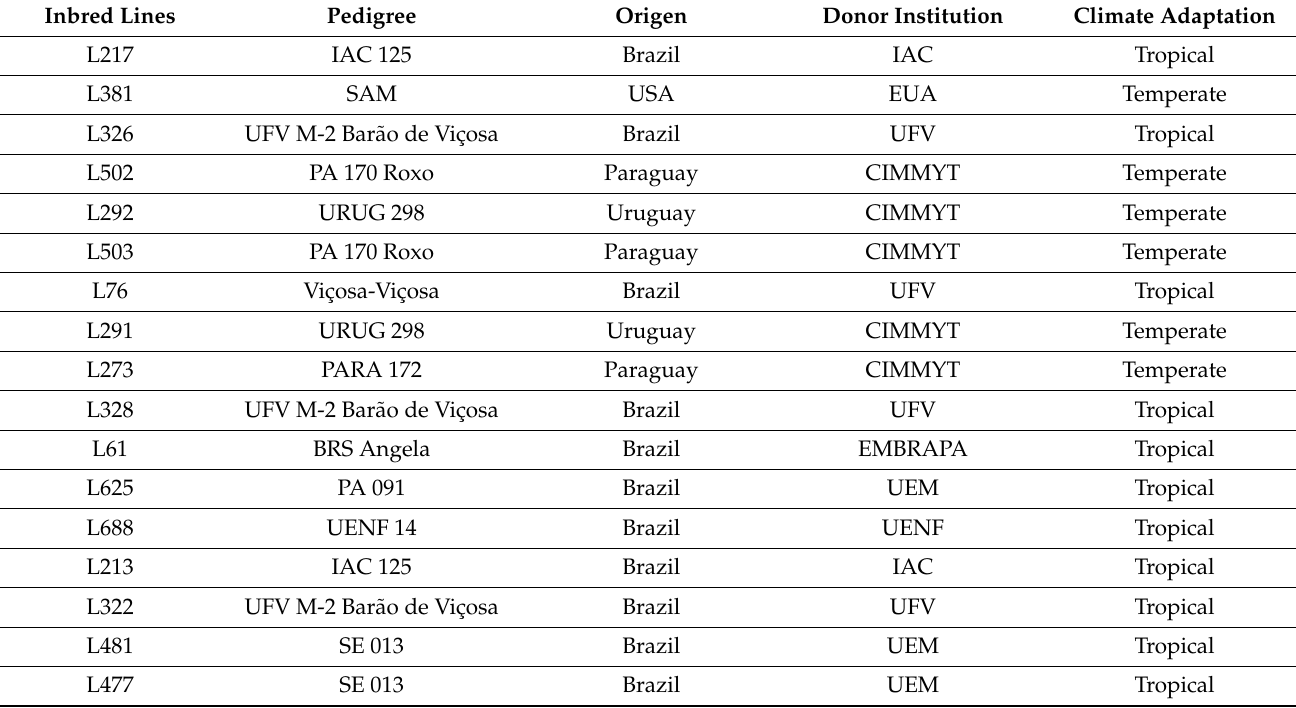
Table A1. Description of popcorn lines and information on generation, country of origin, origin, and climate